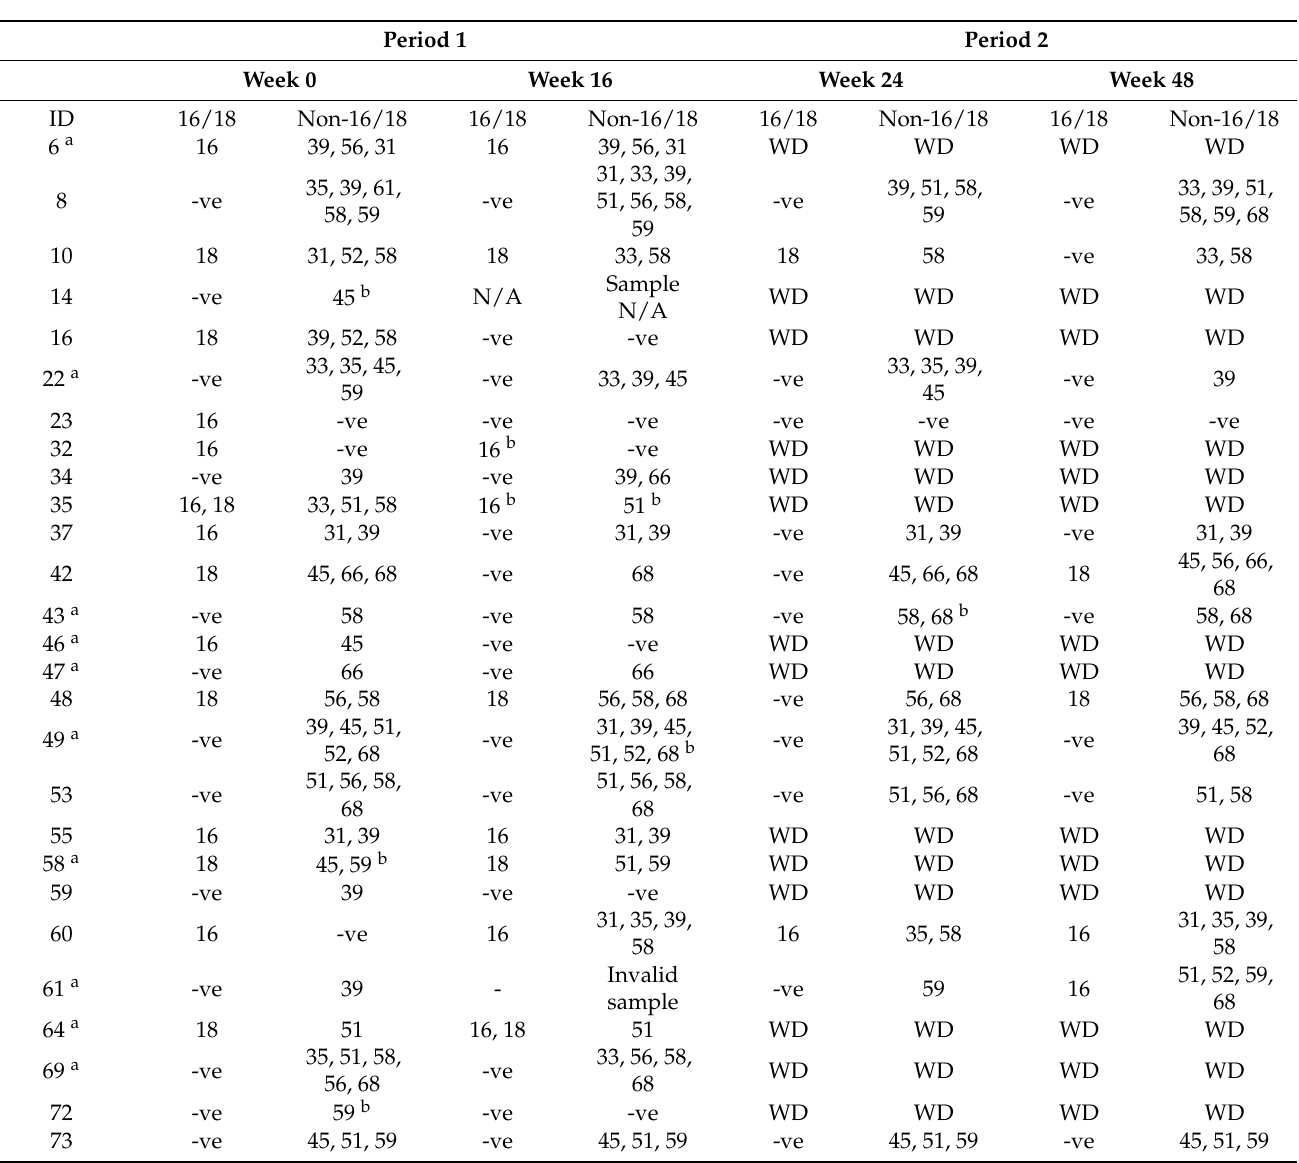
Table 3. High-risk human papillomavirus types present in the anal samples of men who have sex with men who provided at least two anal